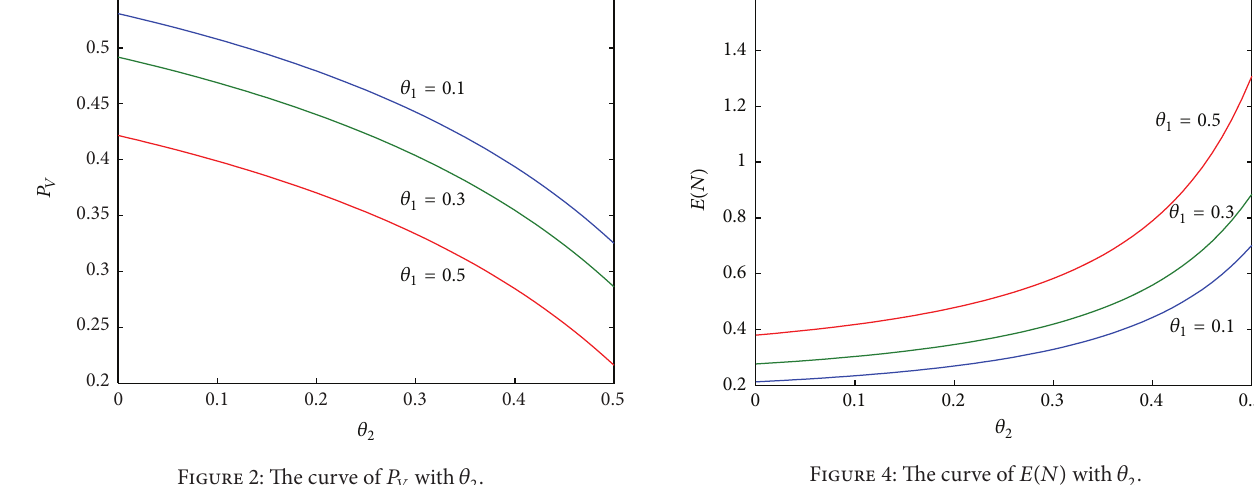
Figure 2: The curve of 𝑃 𝑉 with 𝜃 2 .